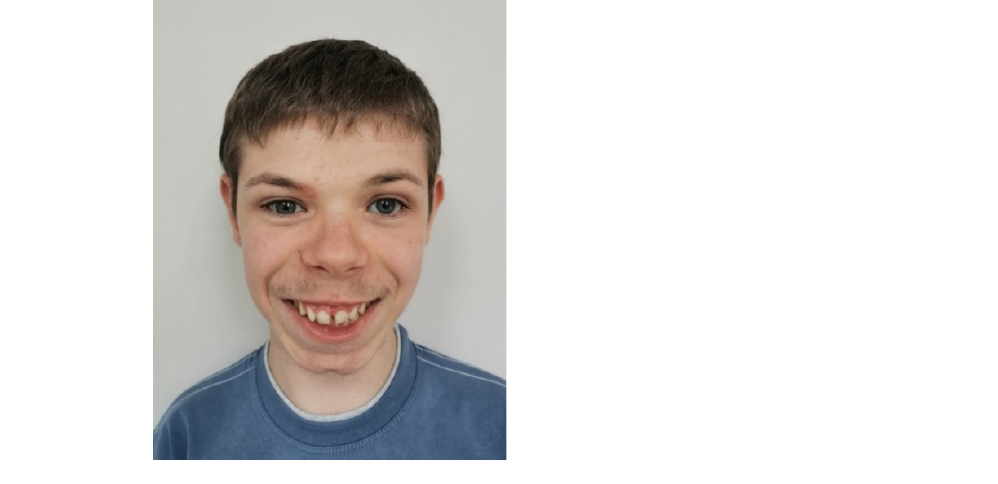
Figure 1. A 16-year-old boy with phenylketonuria and Alazami syndrome (the photo published with consent of the patient’s parents).